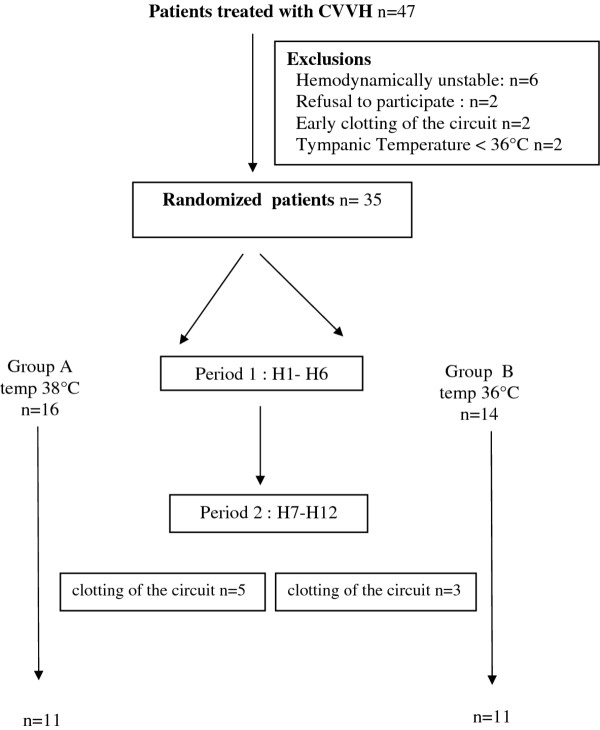
Flow chart of the study. Temp = temperature level set in the heating device of hemofiltration.